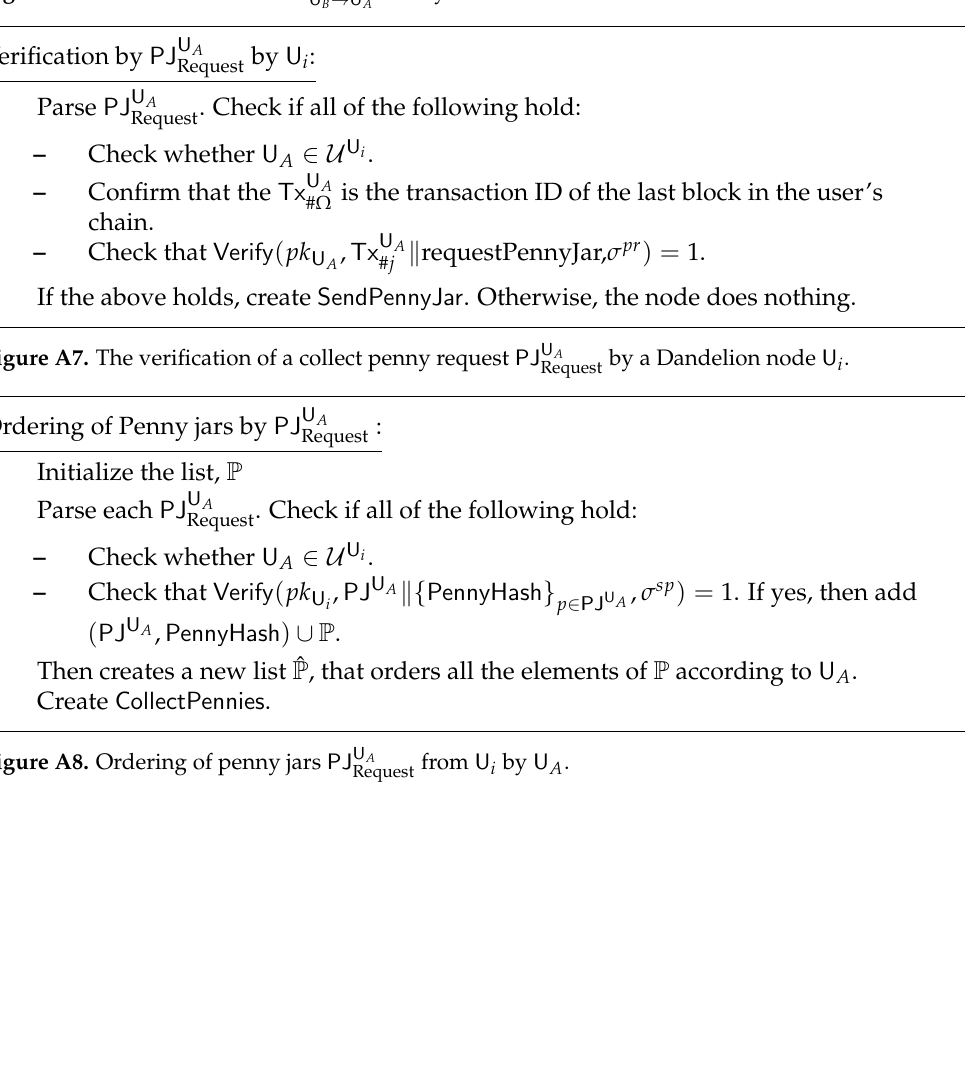
Figure A6. The verification of Tx AbortFinalize U